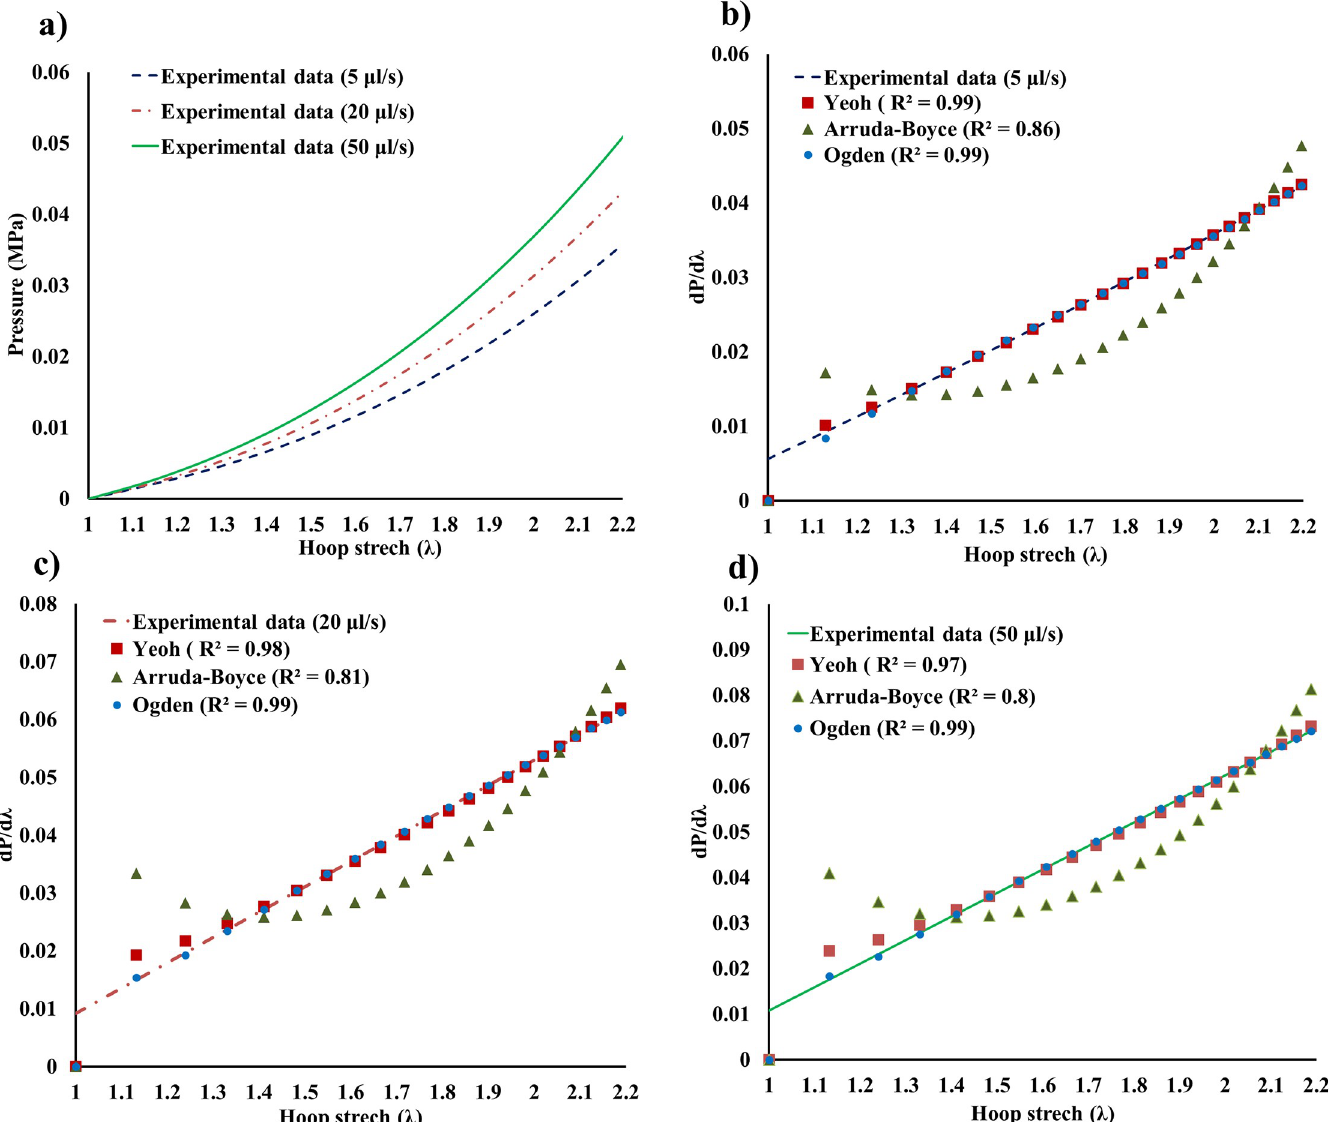
Fig 6. Experimental data. a) Experimental data Pressure vs stretch (P– λ ). Segments b, c and d show the agreement between the SEFs and the instantaneous rate of change derived from the experimental data at injection rates of 5 μ l/s, 20 μ l/s and 50 μ l/s, respectively.